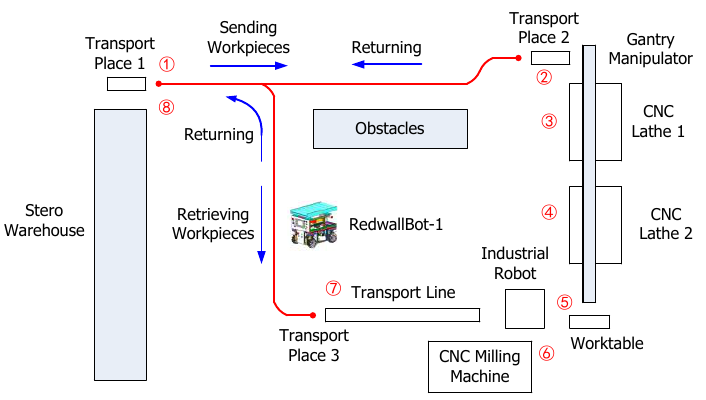
Figure 9. The sequential movement process of the workpieces in the system.